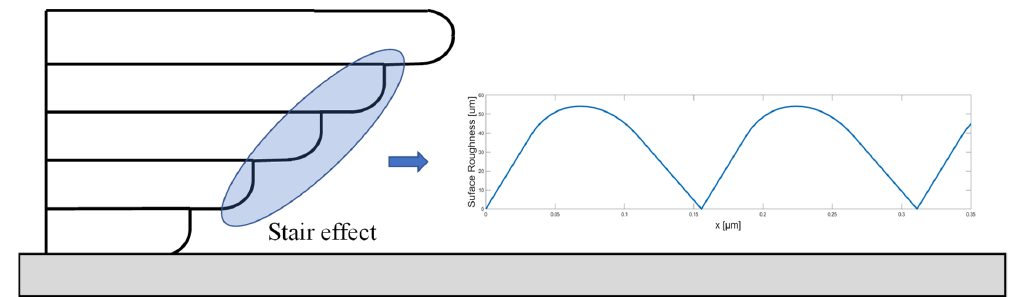
Figure 10. Numerical estimation of surface